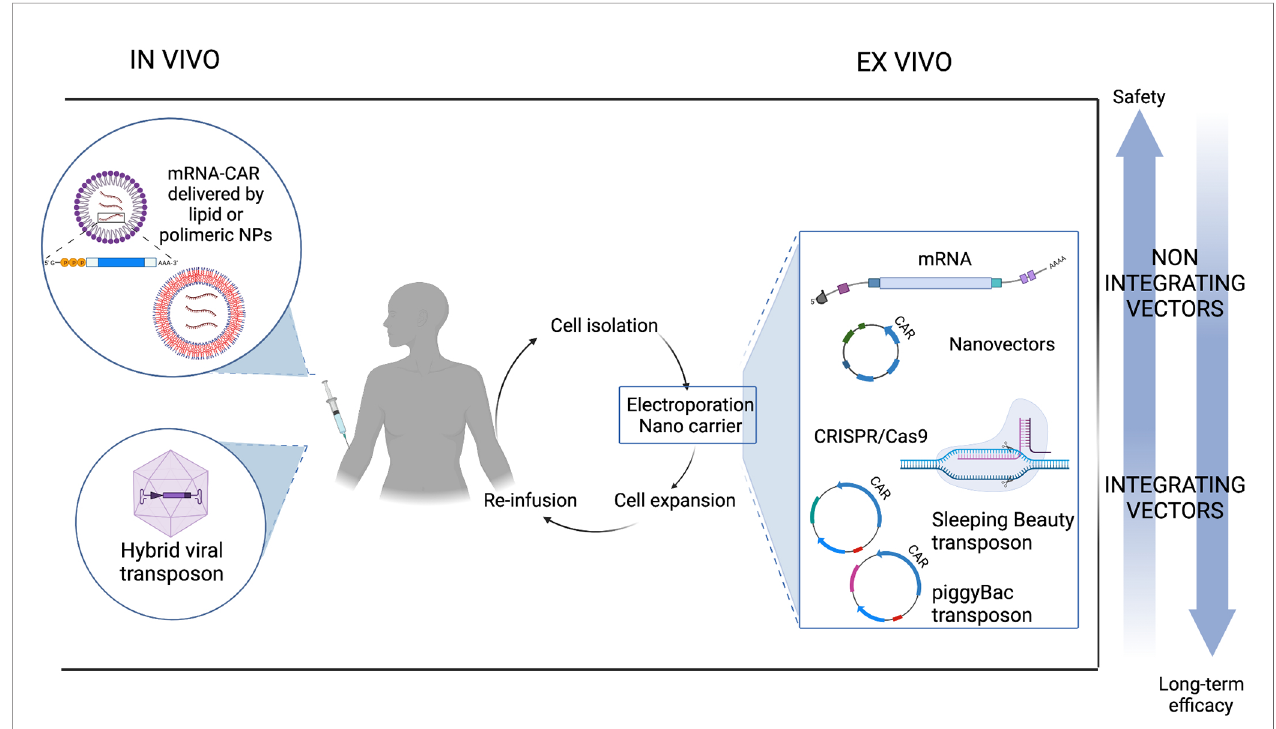
FIGURE 4 | Non-viral CAR T cell